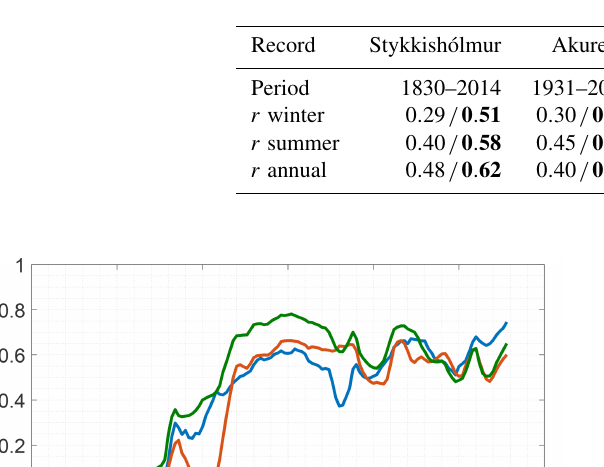
Table 4. Correlation coefficients between the δ 18 O stack and instrumental temperature records ( p< 0 . 05) both at a 1-year resolution and with a 5-year moving mean applied (in bold).